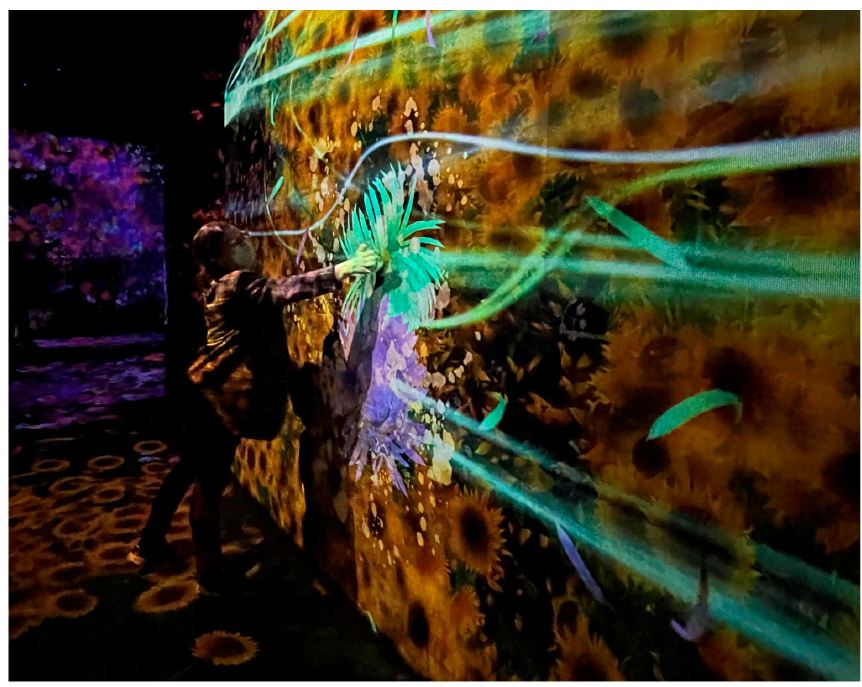
Figure 3. teamLab, Forest of Flowers and People: Lost, Immersed and Reborn , 2017/2021 and Crows are Chased and the Chasing Crows are Destined to be Chased as well, Flying Beyond Borders , 2018/2021, Asian Art Museum of San Francisco; photograph by the author, 2022.